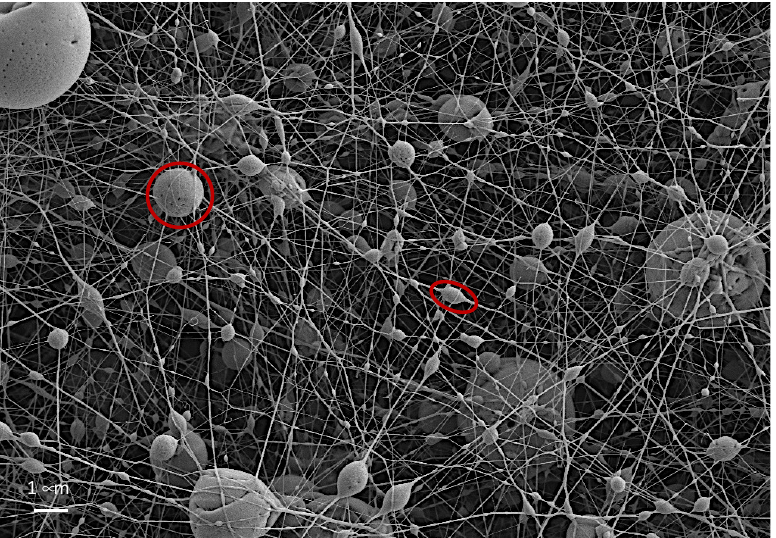
Figure 6. Differentiation between the particles formed in the nanofiber web electrospun with essential oil (thyme 14 kV). Table 3. Size distribution of microspheres from sage and thyme microemulsions electrospun at 14 kV or 20